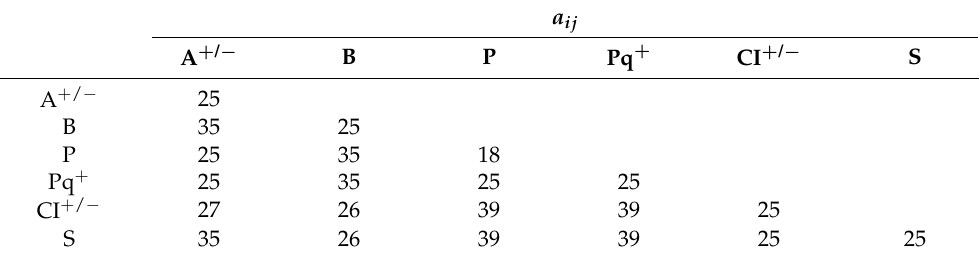
Table 1. Interaction